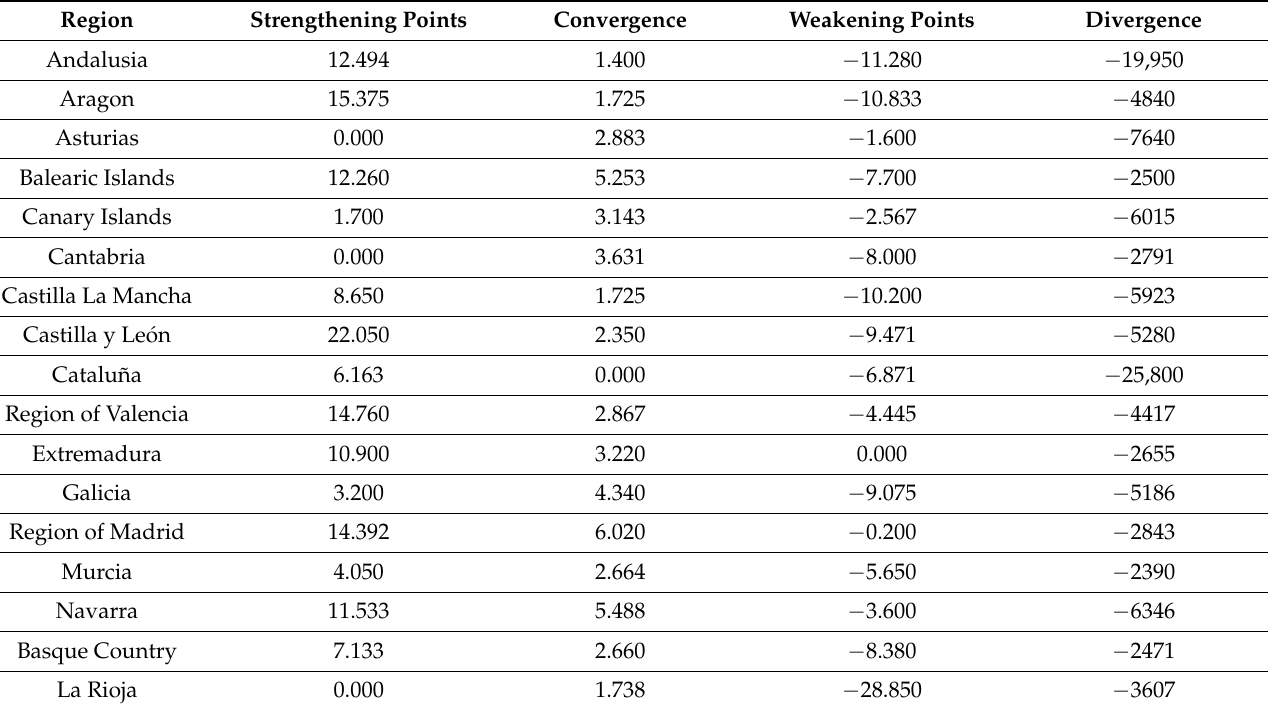
Table 4. The average intensity of strengthening, convergence, weakening and divergence detected by Autonomous Region between 2010 and